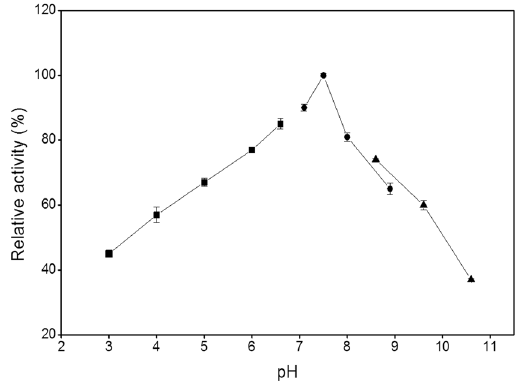
Figure 5. Effect of pH on the activity of TaCBP.